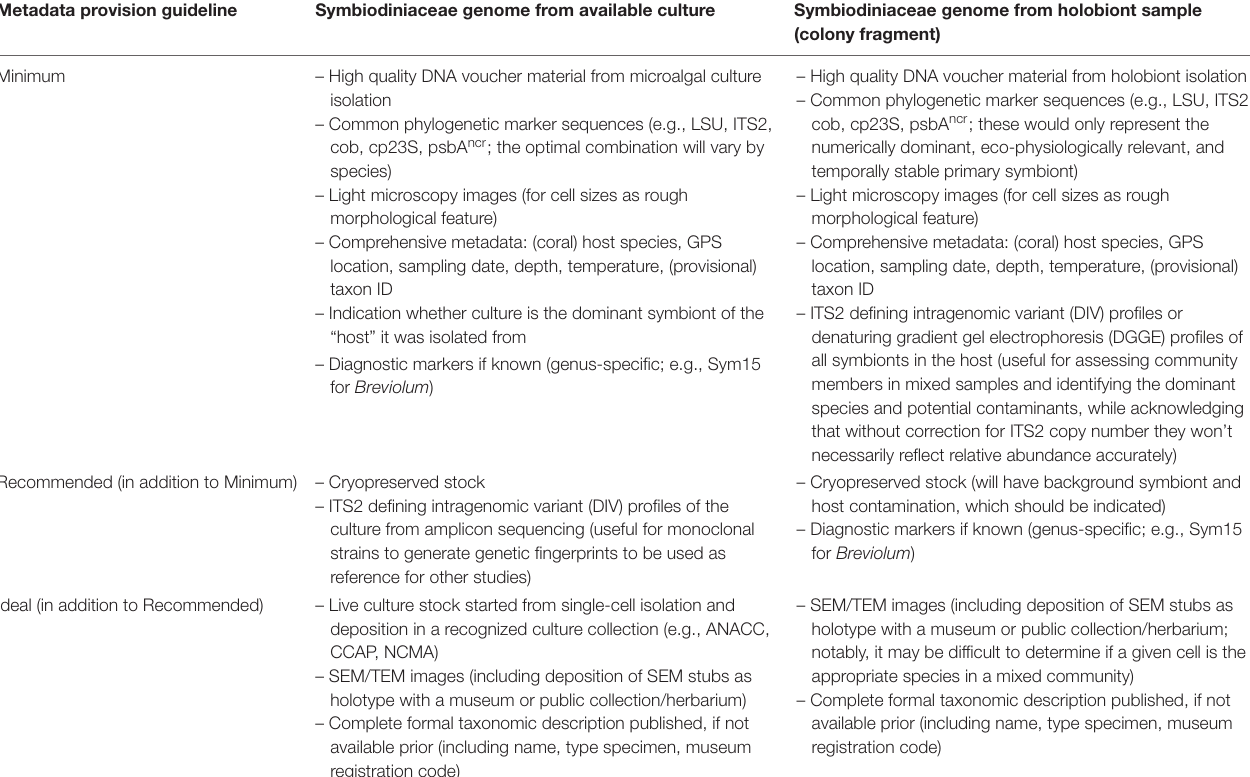
TABLE 2 | Consensus guidelines regarding associated metadata deposition for Symbiodiniaceae specimen collection targeted for genome